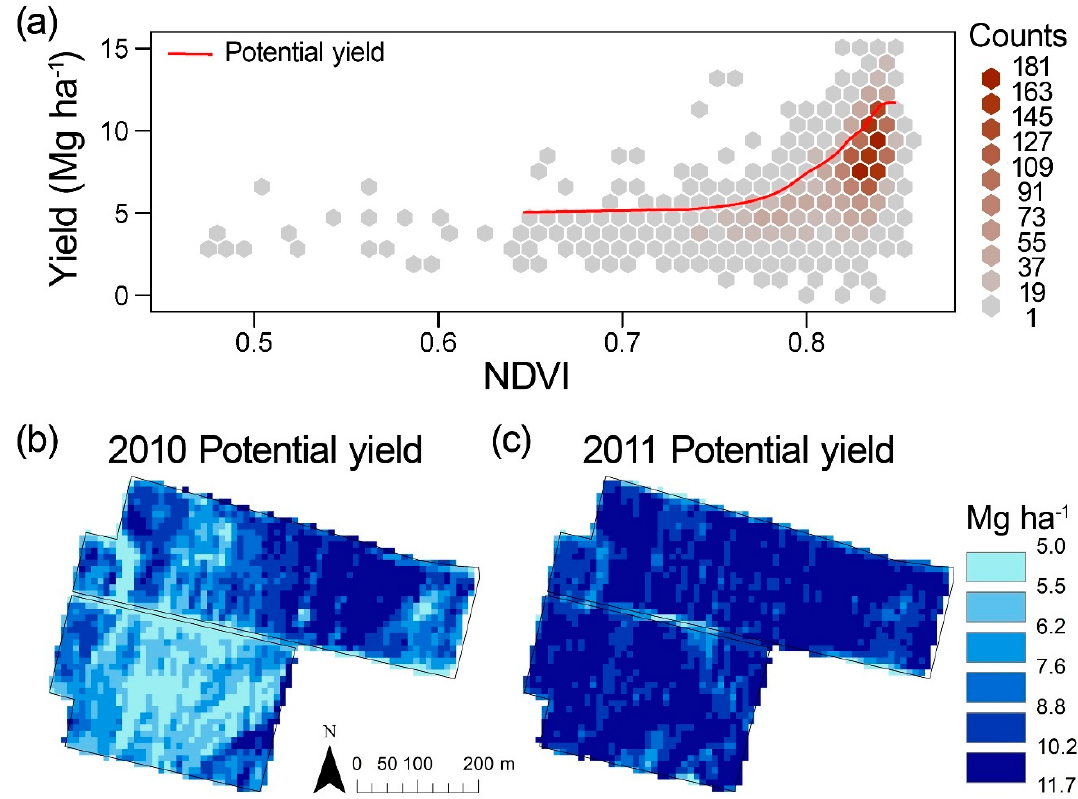
Figure A1. ( a ) Scatterplot between yield and WorldView-2 NDVI for both years. The modeled in-season potential yield is depicted with a solid red line. Potential yield maps calculated for ( b ) 2010 and ( c ) 2011.